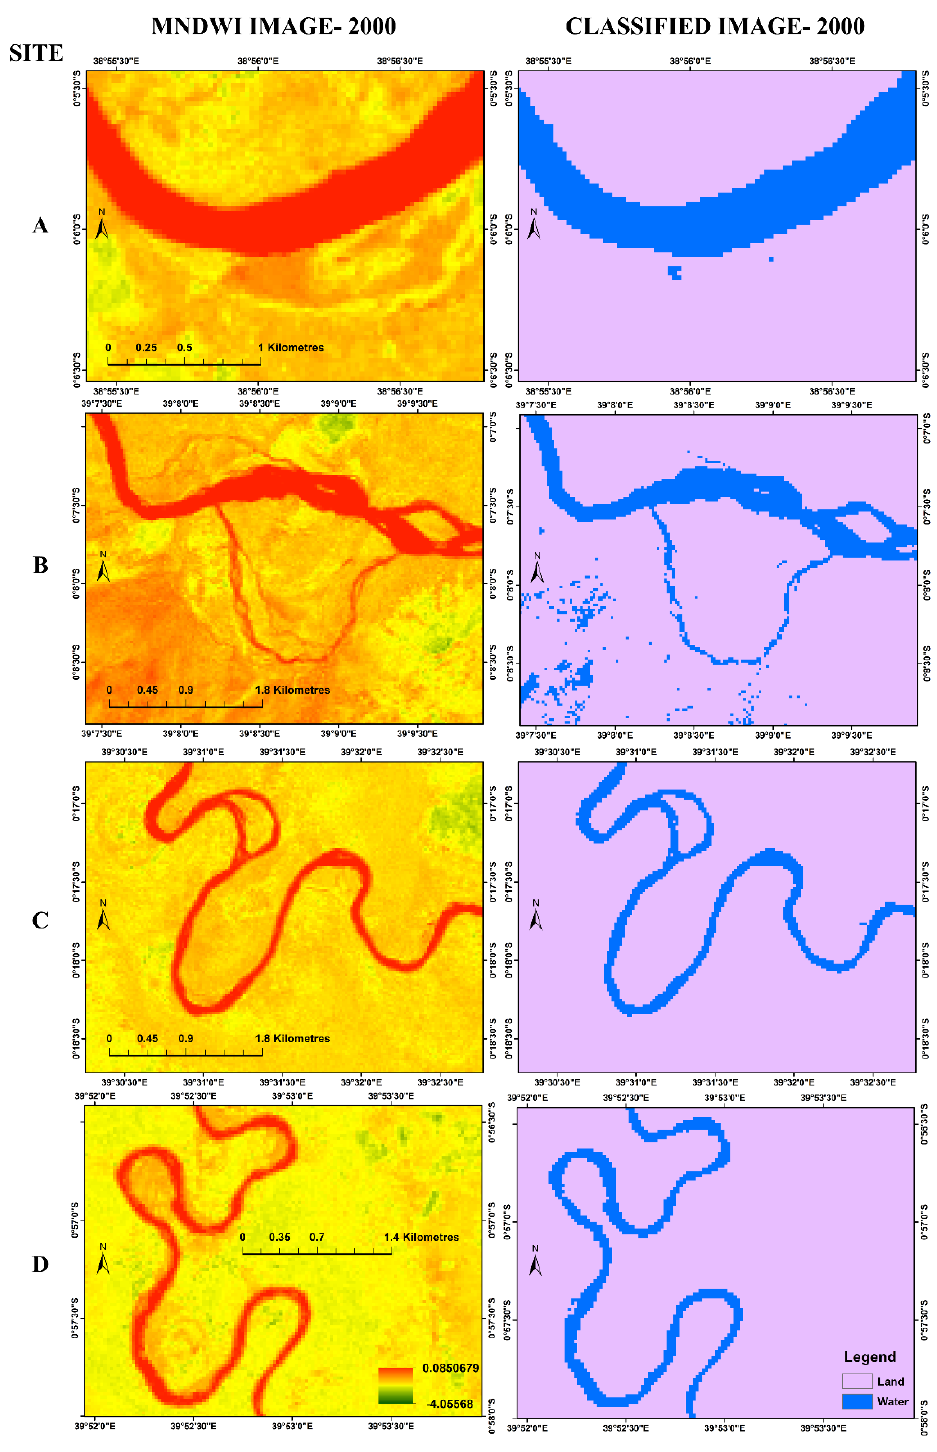
Figure 8. Modified Normalized Difference Water Index (MNDWI) and classified (land and water) images of study Tana River reach in 2000 .